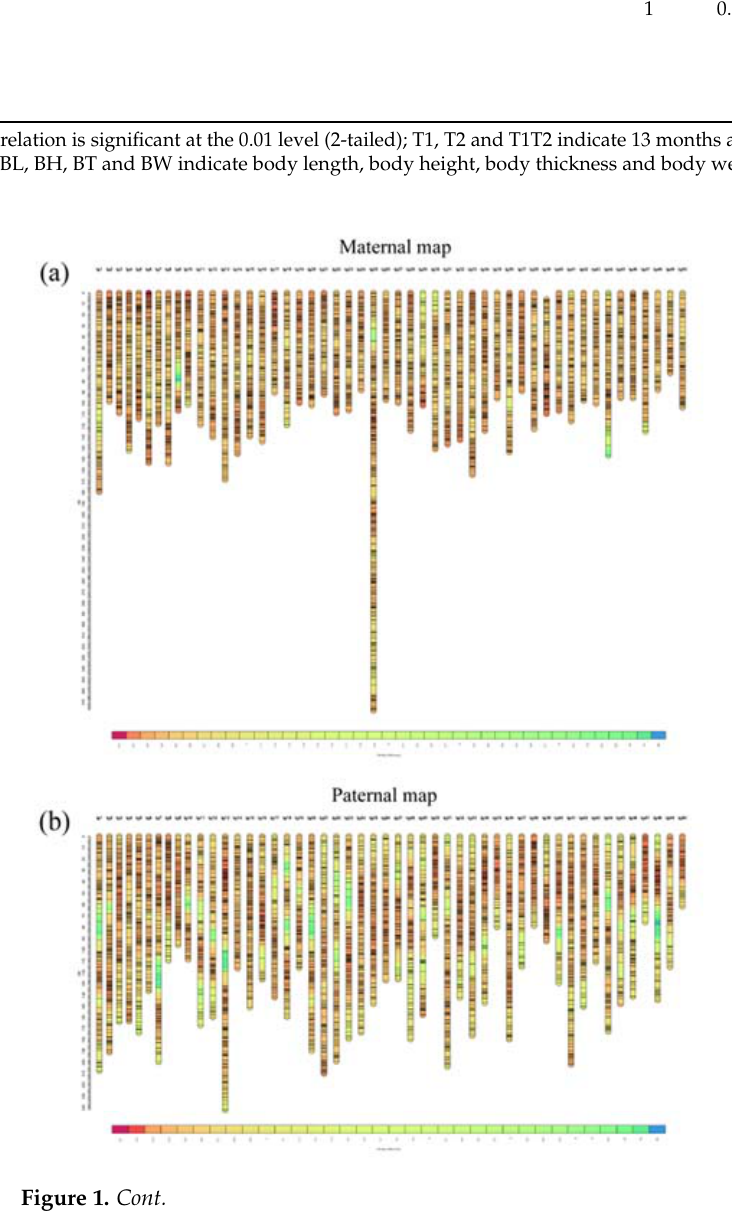
Figure 1. High ‐ density genetic linkage maps of maternal ( a ), paternal ( b ), and HH ( c ) Yellow River carp.